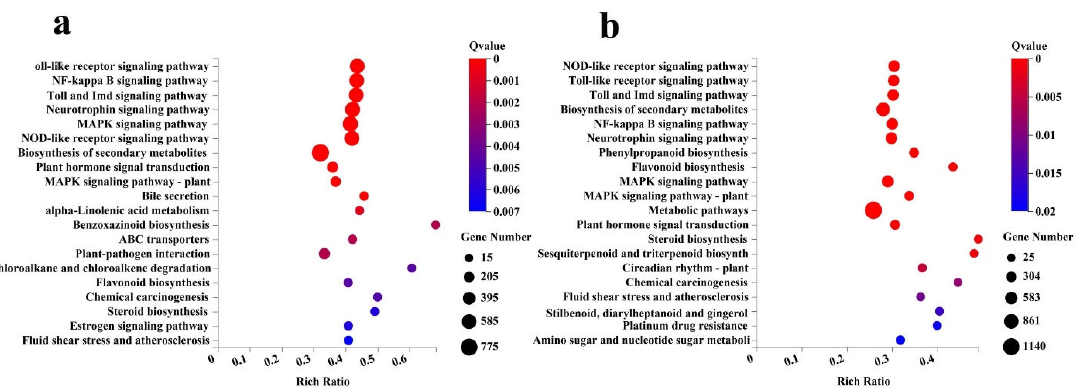
Figure 6. Enrichment of the KEGG annotation of the DEGs. ( a ) Leaves. ( b ) Roots. The x − axis represents the percentage of DEGs belonging to the corresponding pathway, and the y − axis represents the top 20 pathways. The sizes of bubbles represent the number of DEGs in the corresponding pathway, and the colors of the bubbles represent the enrichment Q − value of the corresponding pathway.